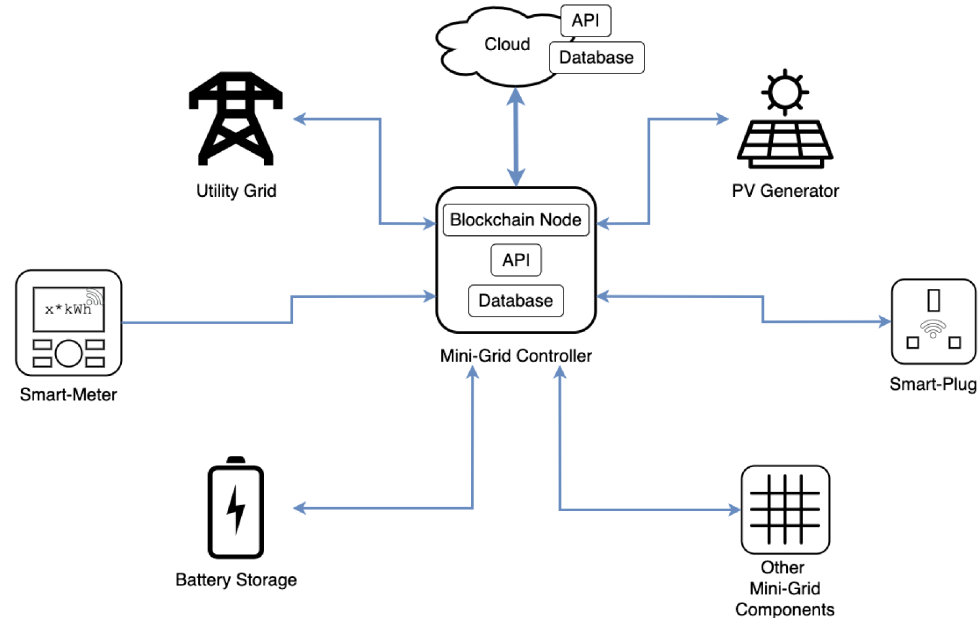
Fig. 2. Mini-grid controller data collection and command